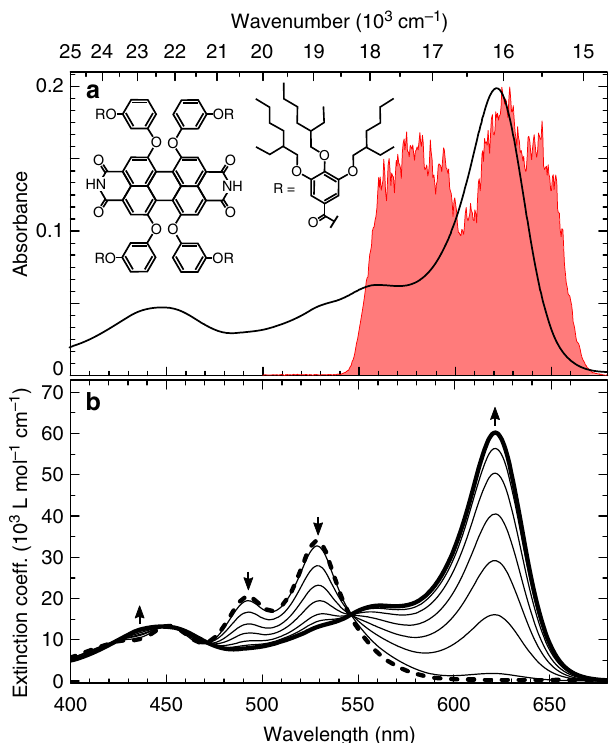
Fig. 3 Absorption properties of MEH-PBI aggregates. a Molecular structure of monomeric MEH-PBI compound (inset), actual absorbance spectrum of MEH-PBI aggregates in MCH (with a molecular concentration of 1.5×10 − 4 M) as used for EEI2D experiments and laser spectrum of pump pulse (red). b Concentration-dependent absorption spectra of MEH-PBI in MCH at 20 °C in the concentration range from 6 × 10 − 6 to 1.7 × 10 − 4 M. Arrows indicate spectral changes with increasing